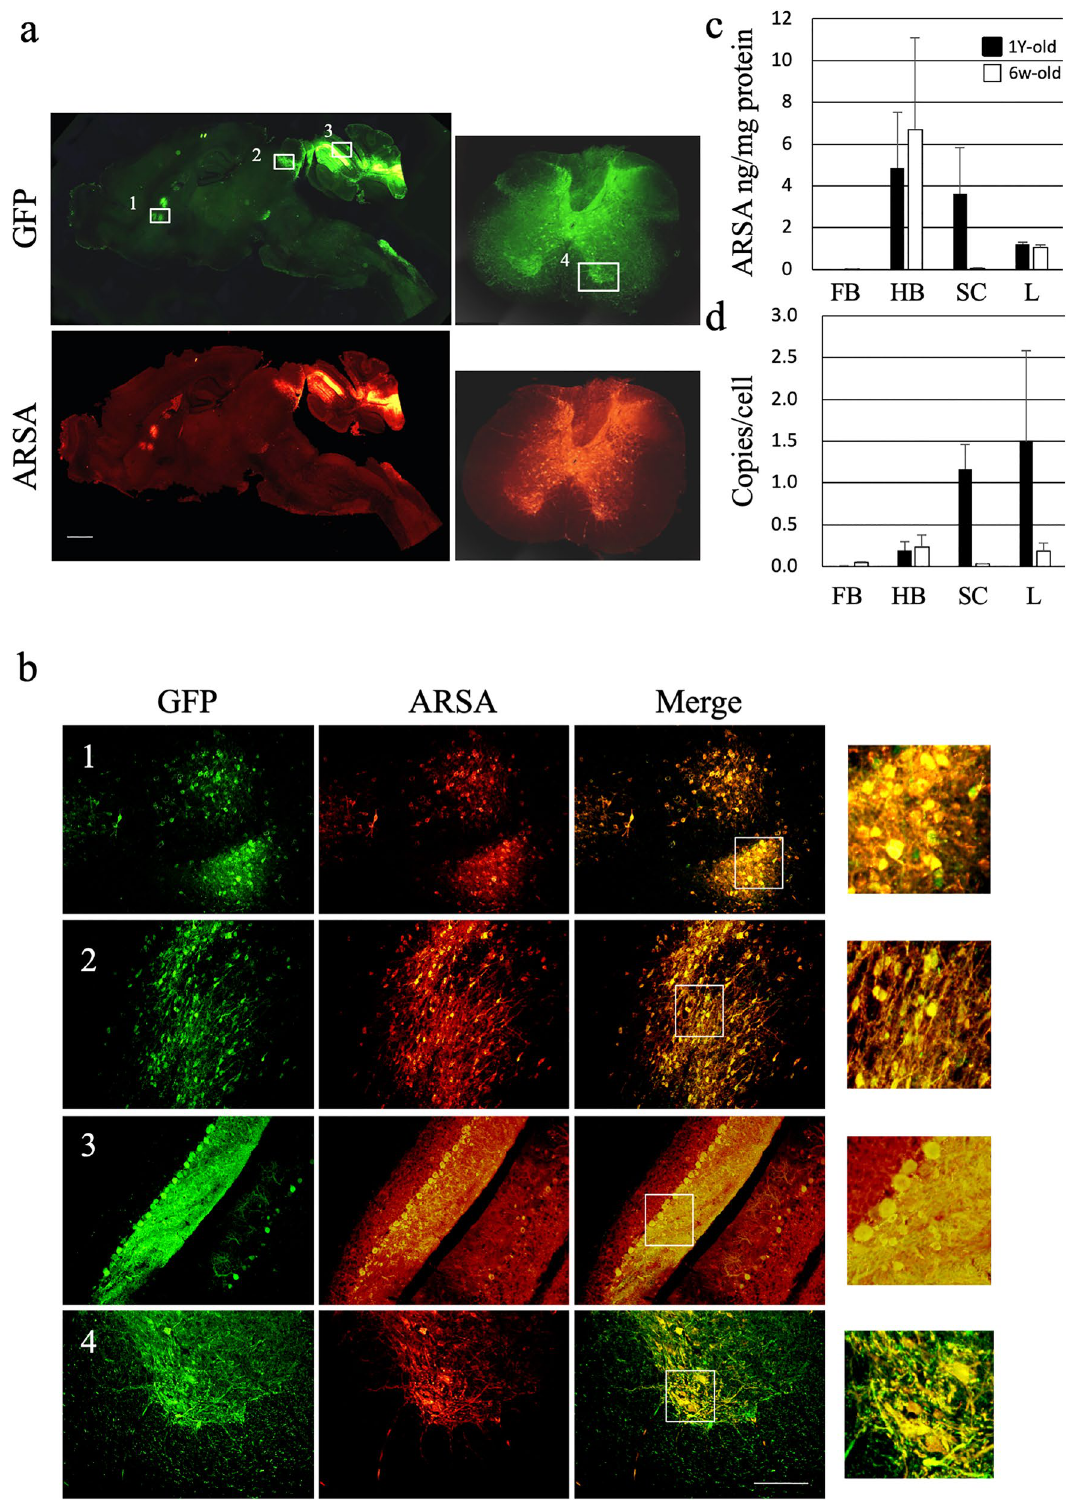
Figure 2. Expression of GFP and ARSA in the brains of treated MLD mice. AAV9/ARSA (encoding ARSA and GFP) were intrathecally injected via suboccipital puncture into 1-year-old MLD mice. ( a ) representative images of immunostaining for GFP and ARSA in sagittal brain and spinal cord sections taken 3 months after injection of AAV9/ ARSA. Boxes indicate the approximate regions from which the higher magnification images shown in b were acquired. ( b ) 1, caudate putamen (striatum); 2, inferior colliculus; 3, cerebellum; 4, ventral horn of the cervical spinal cord. Bar: 200 μM. Panels on the right highlight the observed co-localization. ( c ) ARSA levels in the indicated brain regions measured with ELISAs in MLD mice treated at 6 week (n = 4) and 1 year (n = 5) of age. ( d ) droplet digital PCR to detect the copy numbers of AAV vector in MLD mice treated at 6 week (n = 4) and 1 year (n = 5) and of age. FB, forebrain; HB, hindbrain; SC, spinal cord; L, liver; ARSA, human arylsulfatase